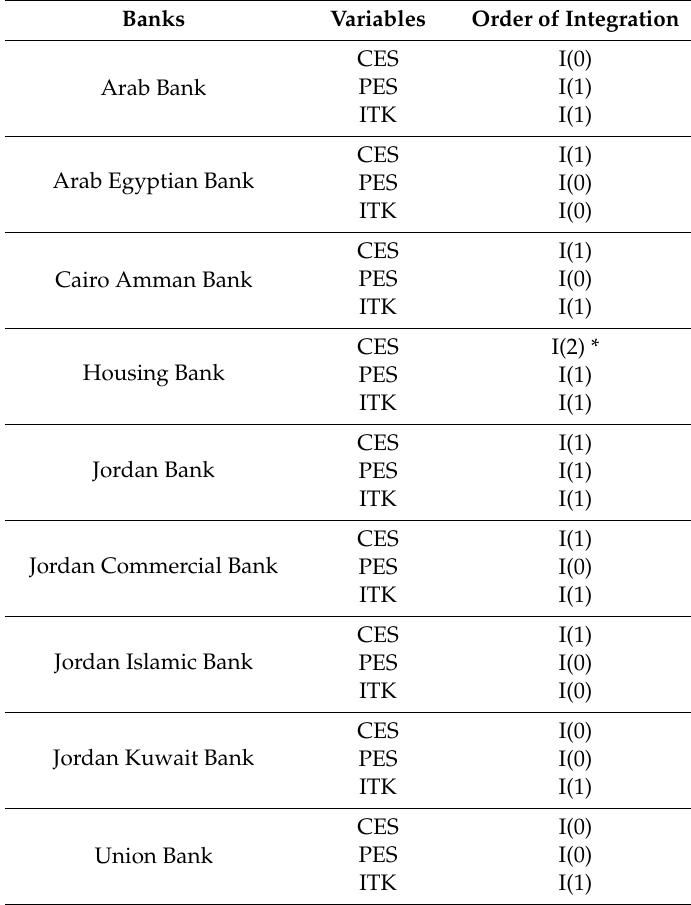
Table 5. Order of integration of variables of